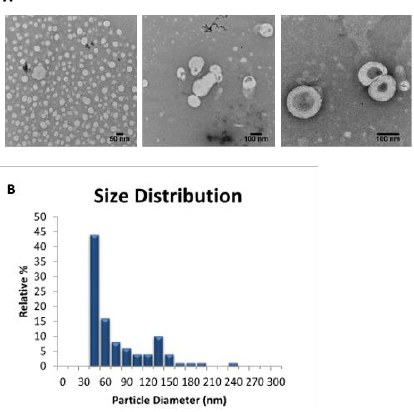
Figure 4. Transmission electron microscopy (TEM) analysis. ( A ) Representative TEM photomicro- graphs of T-RCAR-3. The scale bar represents 50 or 100 nm. ( B ) The particle size and distributions in frequency (%) for T-RCAR-3 derived from the TEM analysis. Only one batch of T-RCAR-3 (#T-RCAR- 3-3) was analyzed by TEM (n =